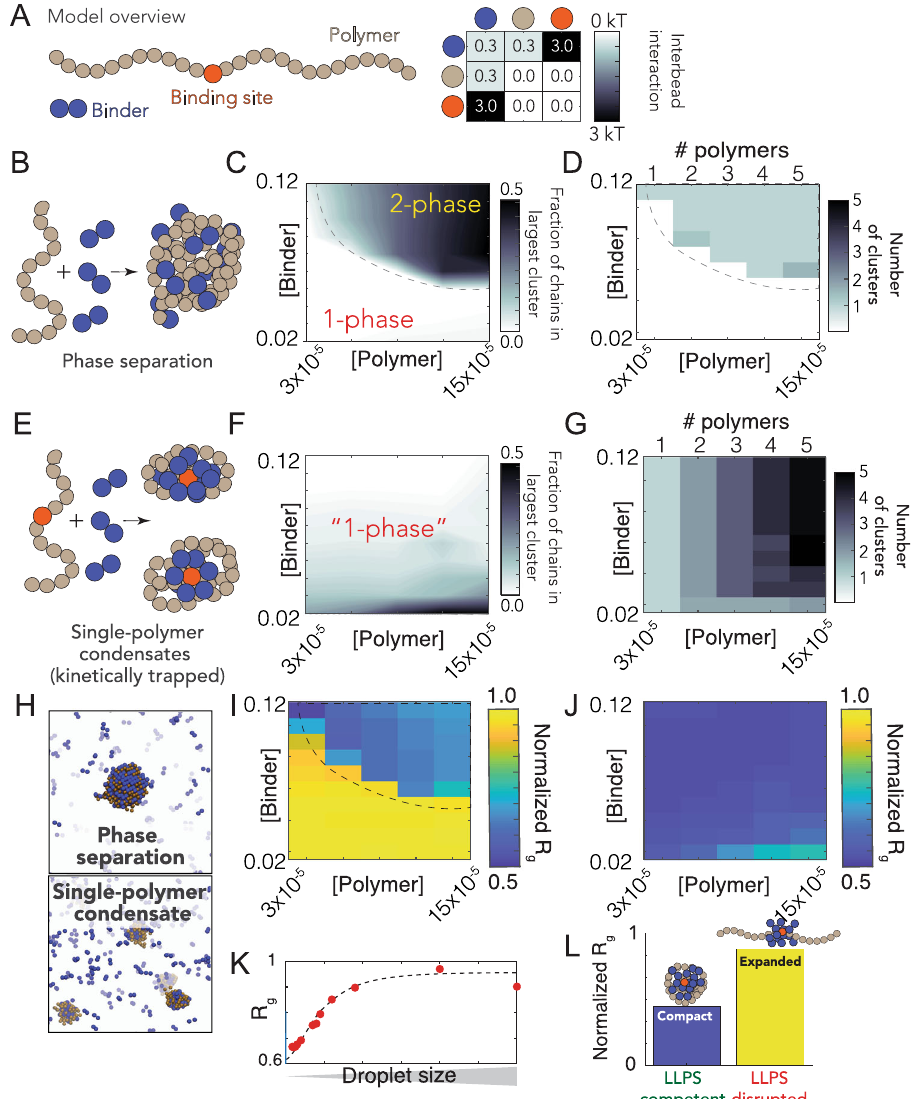
Fig. 6 A simple polymer suggests symmetry breaking can promote single-polymer condensates over multi-polymer assemblies. A Summary of our model setup, which involves long polymers (61 beads per molecules) or short binders (2 beads per molecules). Each bead is multivalent and can interact with every adjacent lattice site. The interaction matrix to the right de fi nes the pairwise interaction energies associated with each of the bead types. B Concentration-dependent assembly behavior for polymers lacking a high-af fi nity binding site. Schematic showing polymer architecture (brown) with binder (blue). C Phase diagram showing the concentration-dependent phase regime — dashed line represents the binodal (phase boundary) and is provided to guide the eye. D Analysis in the same 2D space as panel C , assessing the number of droplets at a given concentration. When phase separation occurs, a single droplet appears in almost all cases. E Concentration-dependent assembly behavior for polymers with a high-af fi nity binding site (red bead). F No large droplets are formed in any of the systems, although multiple polymer:binder complexes form. G The number of clusters observed matches the number of polymers in the system — i.e., each polymer forms an individual cluster. H Simulation snapshots from equivalent simulations for polymers with (top) or without (bottom) a single high-af fi nity binding site. I Polymer dimensions in the dense and dilute phase (for the parameters in our model) for polymers with no high-af fi nity binding site. Note that compaction in the dense phase re fl ects fi nite-size effects, as addressed in panel K , and is an artifact of the relatively small droplets formed in our systems (relative to the size of the polymer). The droplets act as a bounding cage for the polymer, driving their compaction indirectly. J Polymer dimensions across the same concentration space for polymers with a single high-af fi nity binding site. Across all concentrations, each individual polymer is highly compact. K Compaction in the dense phase (panel I ) is due to small droplets. When droplets are suf fi ciently large, we observe chain expansion, as expected from standard theoretical descriptions. L Simulations performed under conditions in which nonspeci fi c interactions between binder and polymer are reduced (interaction strength = 0 kT). Under these conditions phase separation is suppressed. Equivalent simulations for polymers with a high-af fi nity site reveal these chains are no longer compact. As such, phase separation offers a readout that — in our model — maps to single-polymer